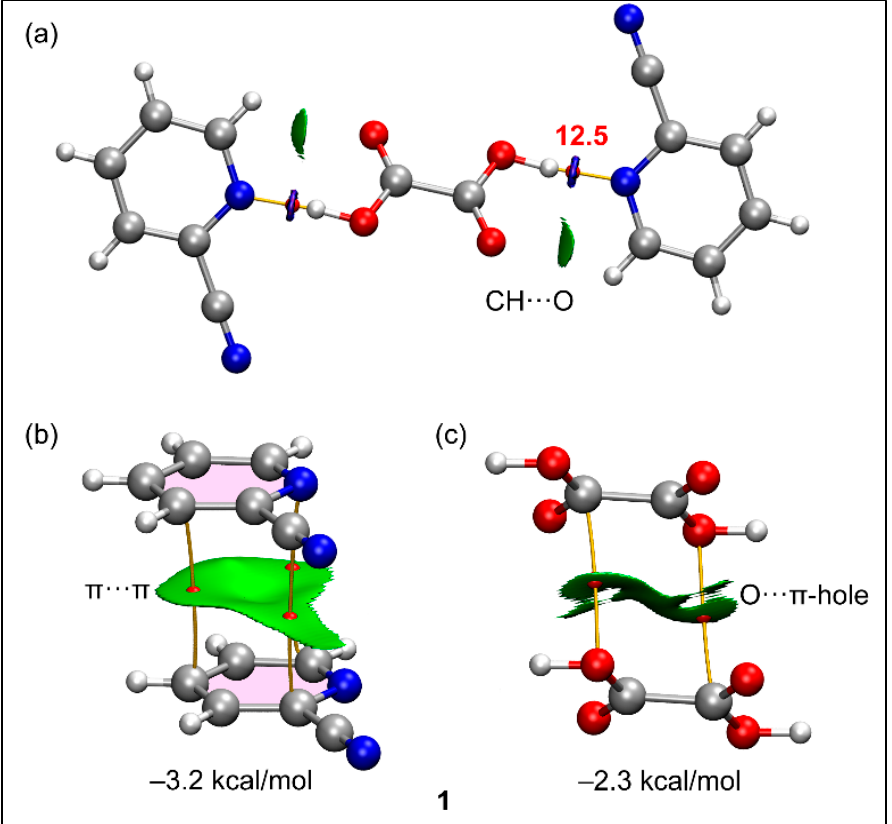
Figure 9. QTAIM and NCI plot analysis of the ( a ) H-bonded, ( b ) π -stacking and ( c ) π -hole assemblies of compound 1 . The QTAIM energies are given in red for the H-bonds (in kcal/mol).